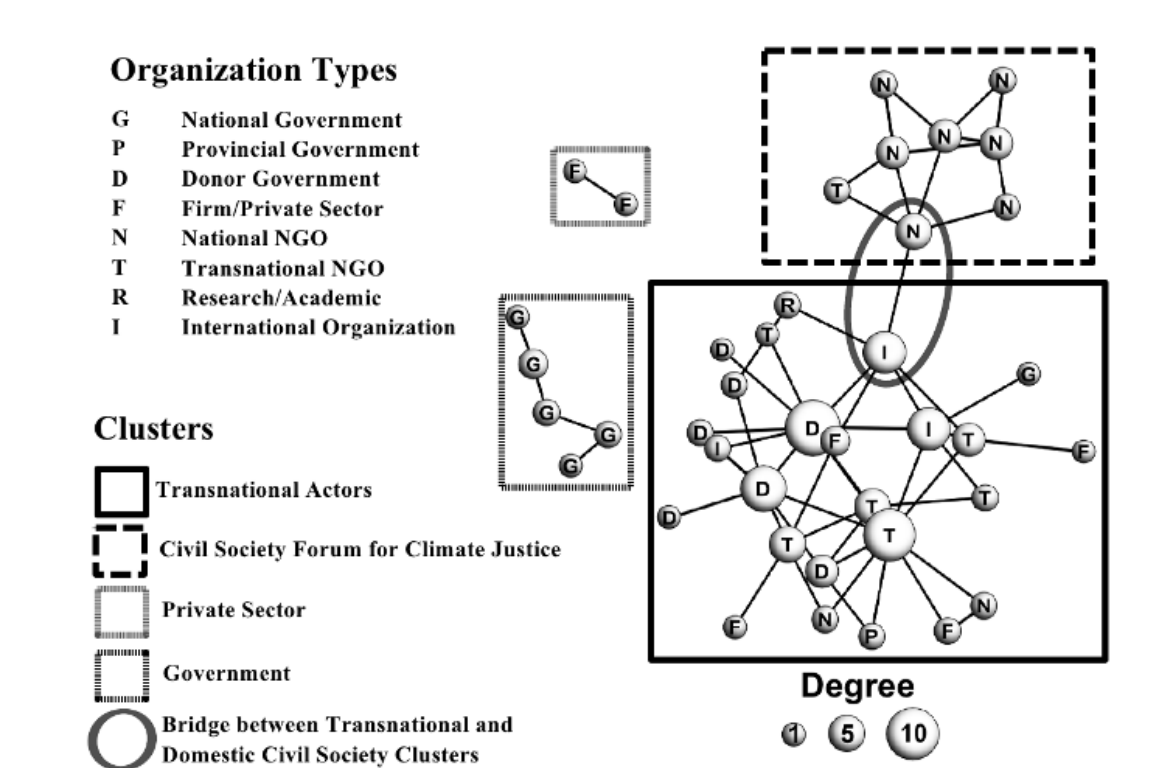
Fig. 3 . Reciprocal information exchange.